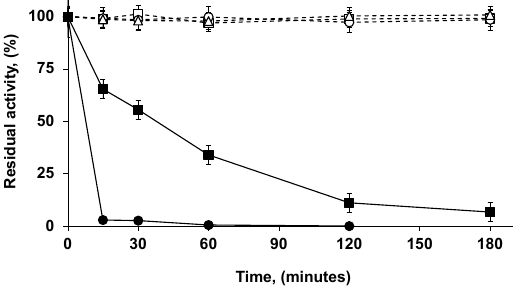
Figure 2. Inactivation courses of the octyl agarose immobilized enzymes at pH 7.0 and 60 ◦ C. Dotted line, empty squares: octyl-CALA; dotted line, empty circles: octyl-CALB; dotted line, empty triangles: octyl-TLL; solid line, solid squares: octyl-RML and solid line, solid circles: octyl-LEU. Other specifications are described in Methods.